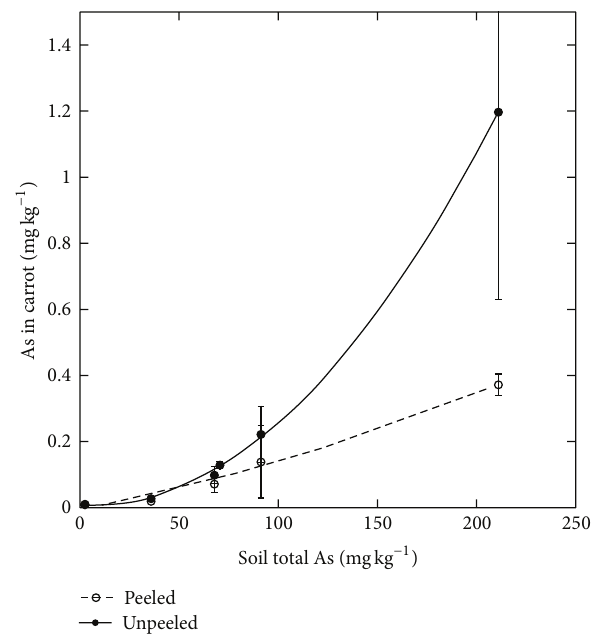
Figure 2: As concentrations (mgkg −1 d.w.) in peeled and unpeeled carrot roots grown on orchard soils containing a range of As